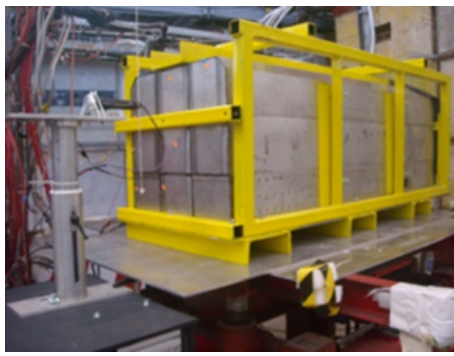
Figure 3. Photo of PSD CBM supermodule at CERN T10 / T9 beam line